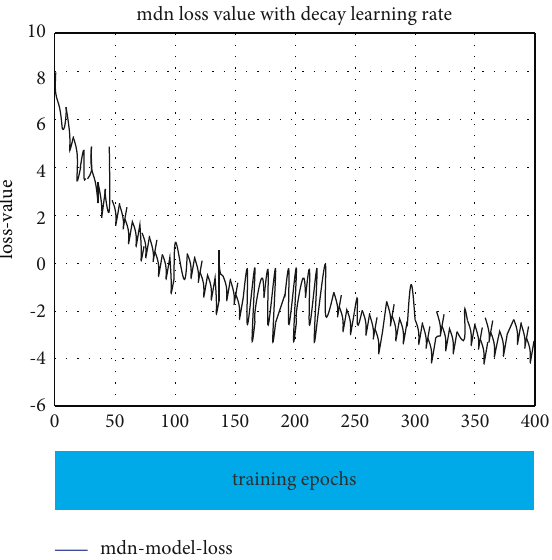
Figure 11: Changes in model loss after